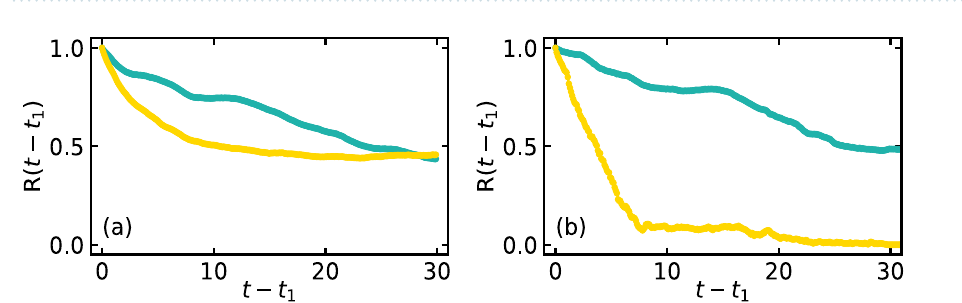
t 1 ) N 0 ( t t 1 )/ N 0 ( t t 1 ) for t > t 1 in the central (green) and the − = − = 7 and ( b ) κ 17 . The other parameter values = =